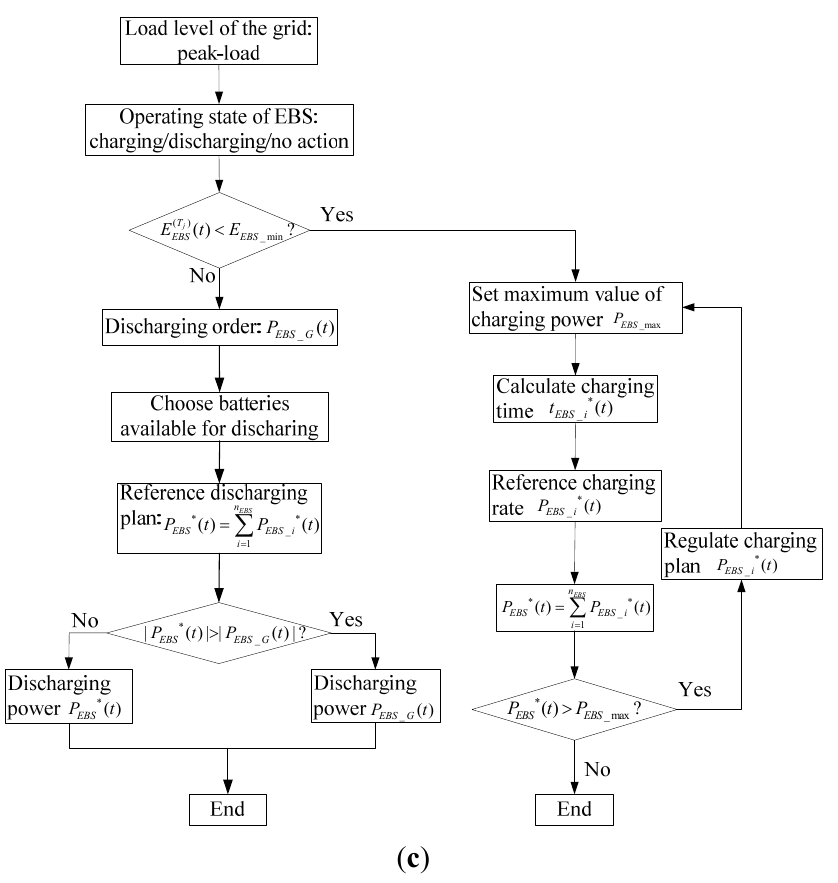
Figure 10. Charging discharging algorithm of EBS at different load status. ( a ) During valley load periods; ( b ) During mediate load periods; ( c ) During peak load period.